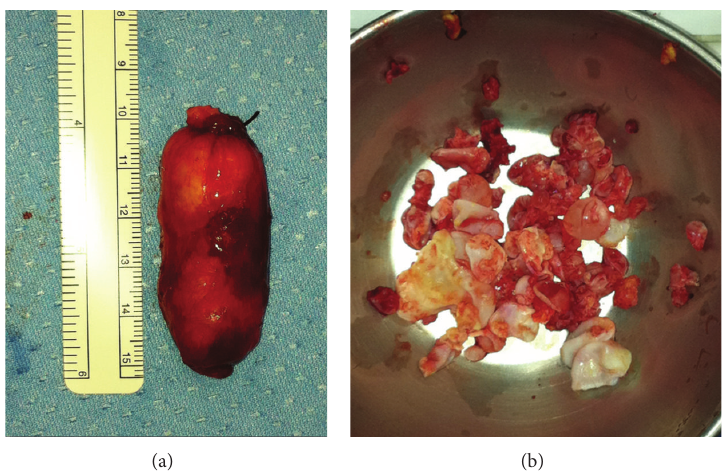
Figure 3: (a) Single hydatid training (2 × 5 cm) and (b) multiple hydatid cysts